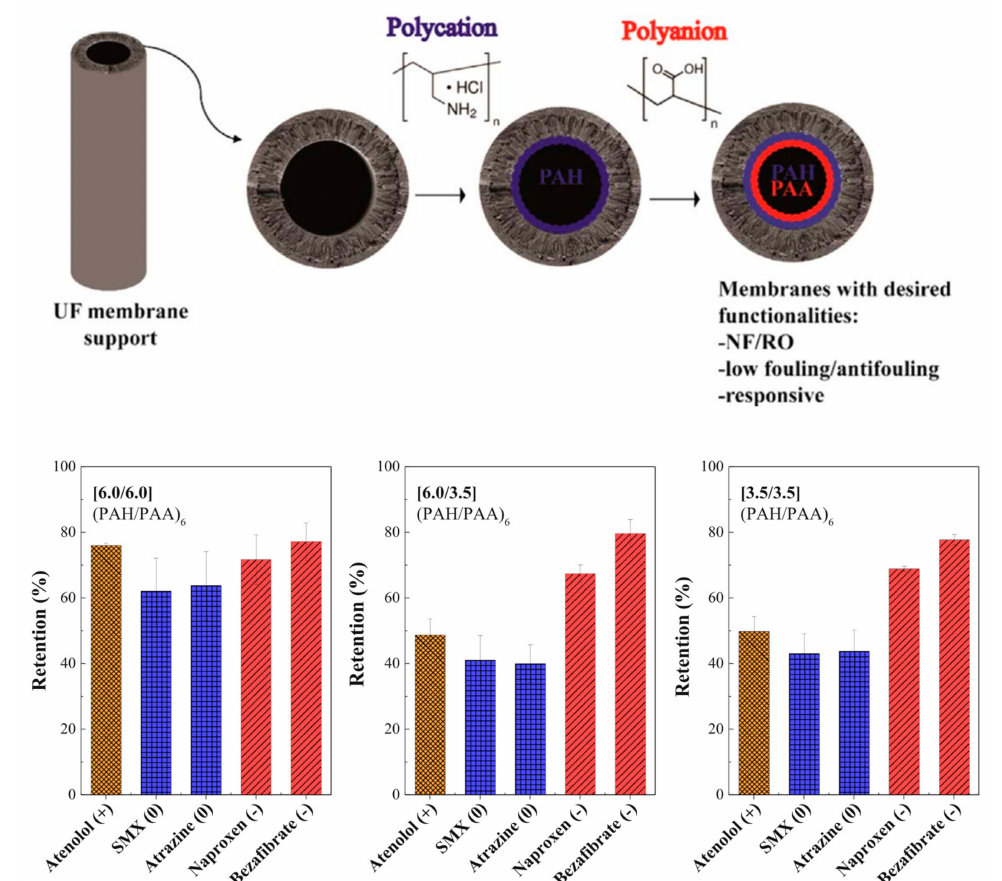
Figure 11. Graphical representation of layer by layer (LBL) deposition of polyelectrolyte nanofiltration membranes (PENMs) on hollow fiber ultrafiltration (UF) membrane support (top layer), retention of different micro-pollutants at pH 5.8 by PENM membranes with 6 (-) bilayers of poly(allylamine)/ poly(acrylic acid) (PAH/PAA) (prepared with different combinations of pH (6.0/6.0), (6.0/3.5), and (3.5/3.5) and ionic strength of 50 mM with 0.1 g L − 1 polymer). Conditions for filtration experiments were: pH 5.8, Re ≈ 3100, and the applied trans-membrane pressure (TMP) of 1.8 bar (bottom layer). Reproduced with permission from Reference